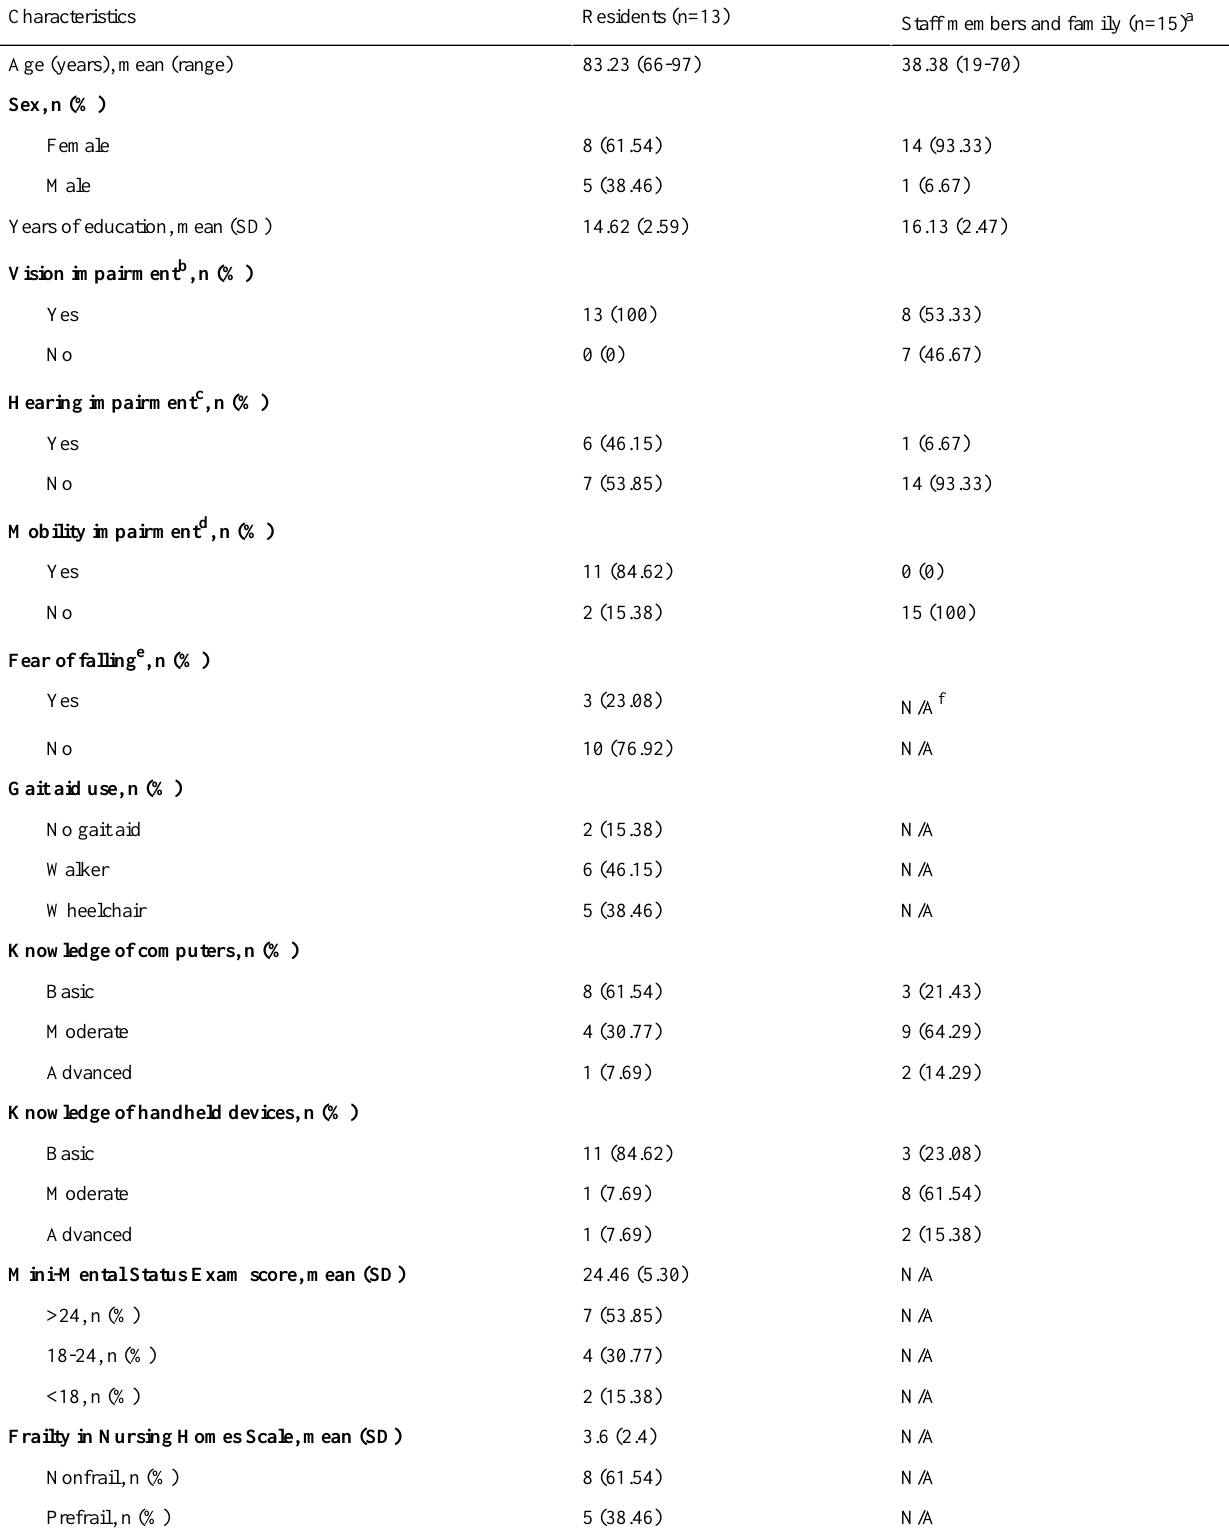
Table 1. Participant demographics and characteristics